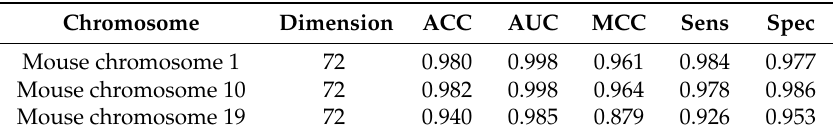
Table 7. Prediction results of three mouse chromosomes using our method. Chromosome Dimension ACC AUC MCC